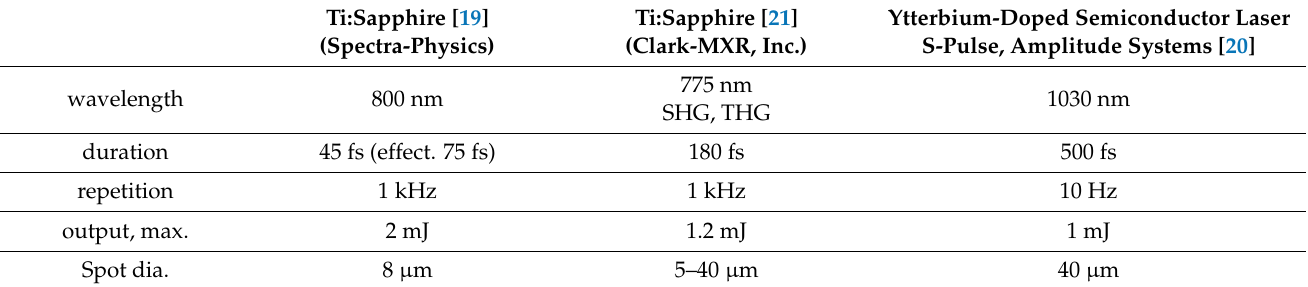
Table 2. Femtosecond laser systems applied in